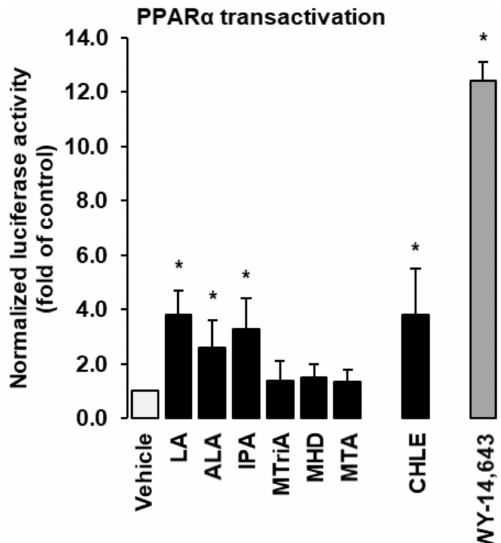
Figure 2. E ff ects of isolated fatty acids, Conidiobolus heterosporus lipid extract (CHLE) and synthetic PPARalpha agonist WY-14,643 on PPARalpha transactivation in Fao cells. Fao cells were transiently transfected with a 3X ACO-PPRE vector and a Renilla luciferase expression vector for normalization using FuGENE6. After transfection, cells were treated either without (vehicle) or with di ff erent isolated fatty acids (50 µ M each), CHLE (500 µ M) or WY-14,643 (50 µ M) for 24 h. Afterwards, cells were lysed, and luciferase activities were determined by dual luciferase assay. Bars represent means ± SD of three independent experiments. * p < 0.05 compared with vehicle control.